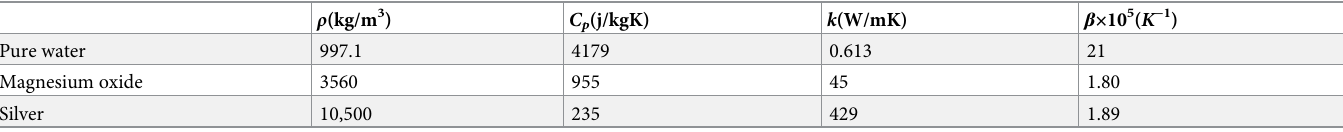
Table 1. The numerical properties of water and hybrid nanofluid